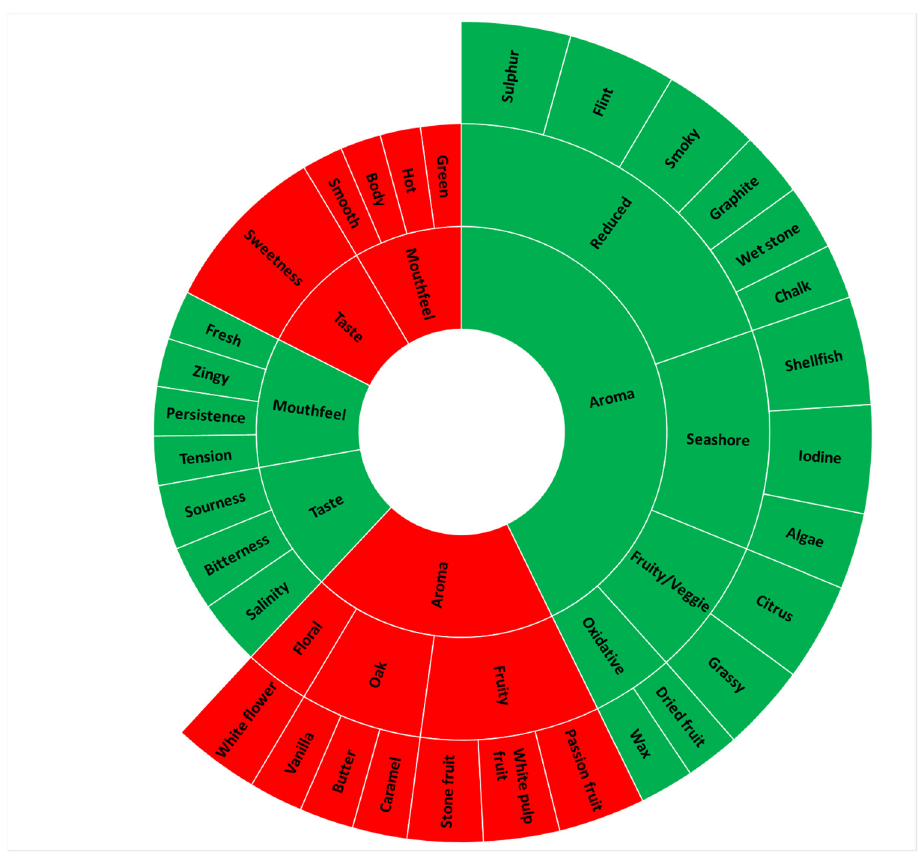
Figure 1. Proposal for a flavour wheel comprising most frequent positive (green) and negative (red) sensory descriptors for mineral white wines retrieved from references listed in Table 1.